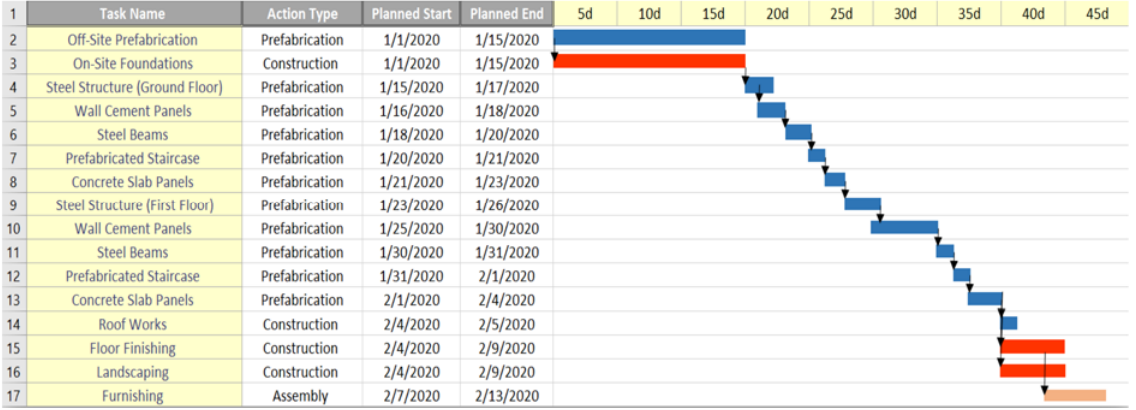
Figure 7. Conventional construction planning method.